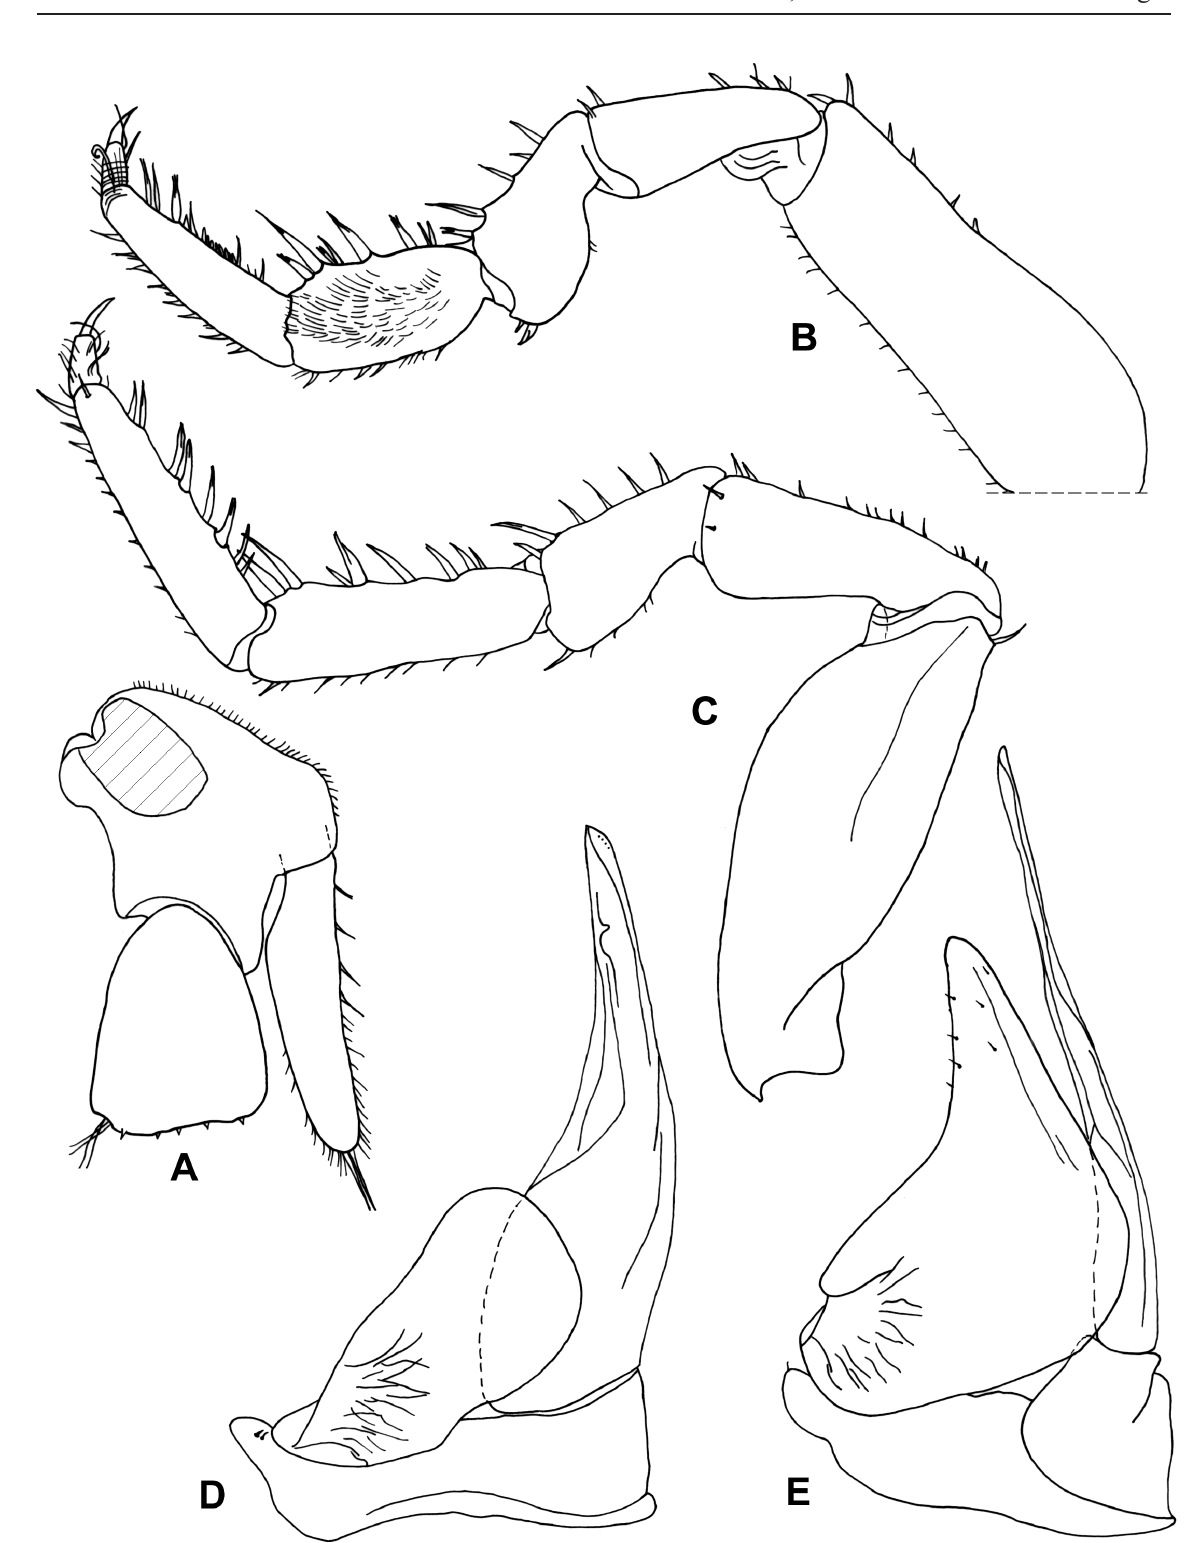
Fig. 34. Trogleluma machadoi (Vandel, 1946) from Algarão do Remexido, Algarve, ♂. A . Uropod. B . Pereopod 1. C . Pereopod 7. D . Pleopod 1. E . Pleopod